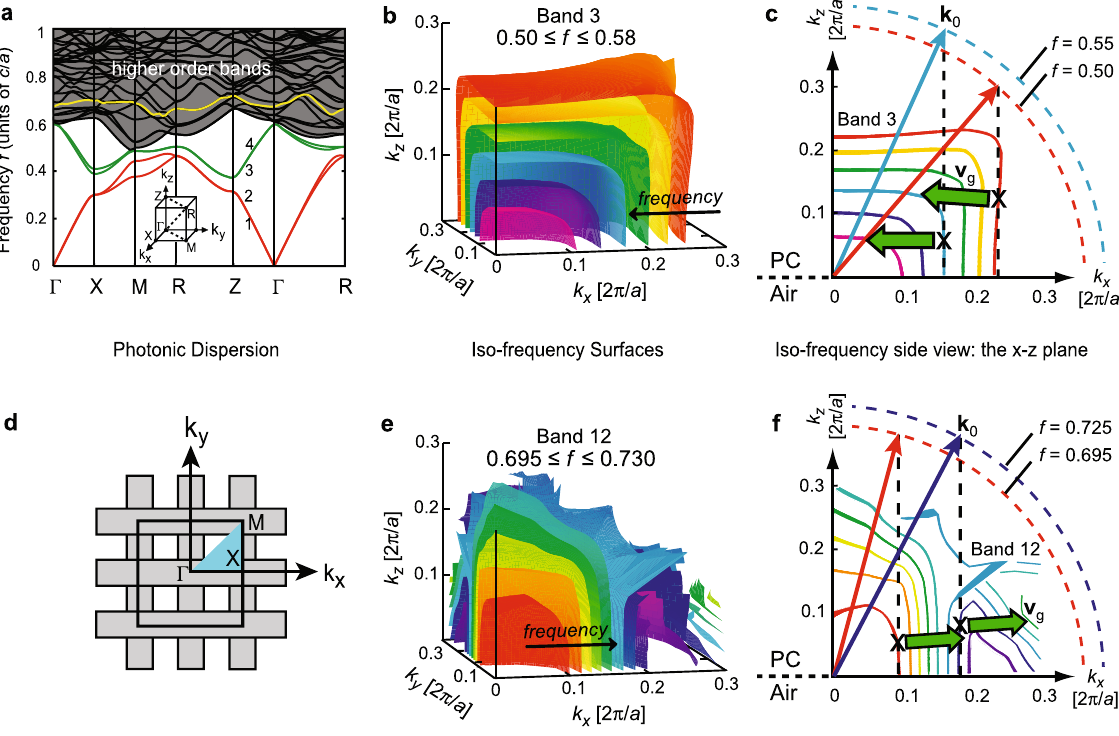
Figure 2. Bandstructure and iso-frequency surfaces of a simple cubic photonic crystal. ( a ) Photonic bandstructure of the simple cubic PC. The normalized frequency f is plotted in units of c / a where c is the speed of light in vacuum and a is the lattice constant. The inset shows the first Brillouin zone of the simple cubic lattice. ( b ) Iso-frequency surfaces for frequencies in band 3. ( c ) Cross-section of the band 3 iso-frequency surfaces demonstrating PIR. ( d ) Schematic of the top surface of the PC, with the x-y plane of the BZ overlaid to show the geometry of the problem. ( e ) Iso-frequency surfaces for frequencies in band 12. ( f ) Cross-section of the band 12 surfaces demonstrating